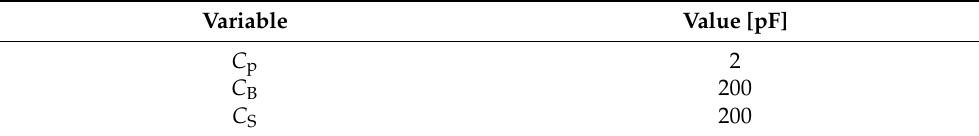
Table 2. Values of coupling capacitances in the power-line and measured subject environment.